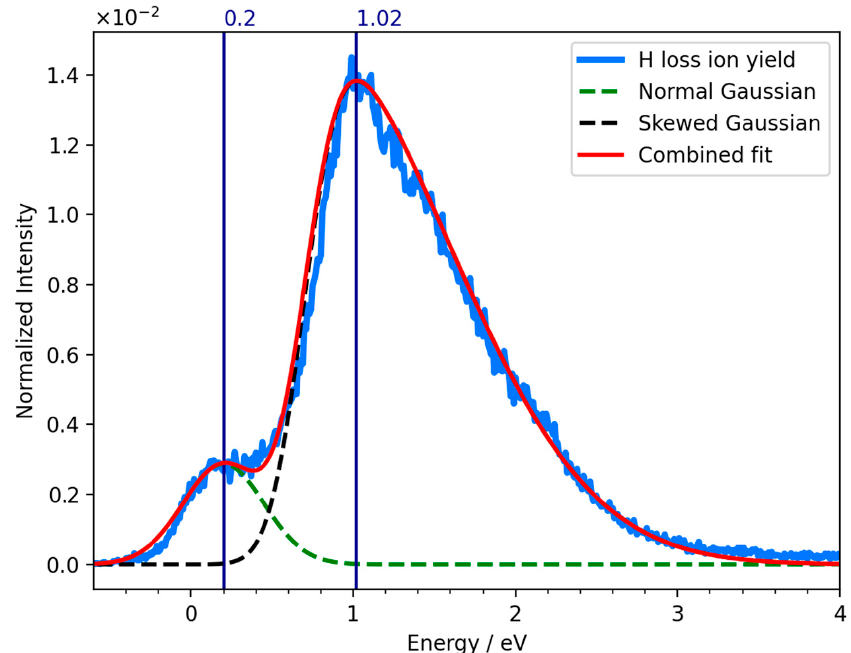
Figure 9. Single fit of a Skewed Gaussian (black dashed line) of the negative ion yield curve (blue line) for the H loss upon DEA from 2-FTP. Additionally, a Normal Gaussian peaking at 0.2 eV (green dashed line) is included to reproduce the impurity contribution at 0 eV. The red line represents the resulting fit.